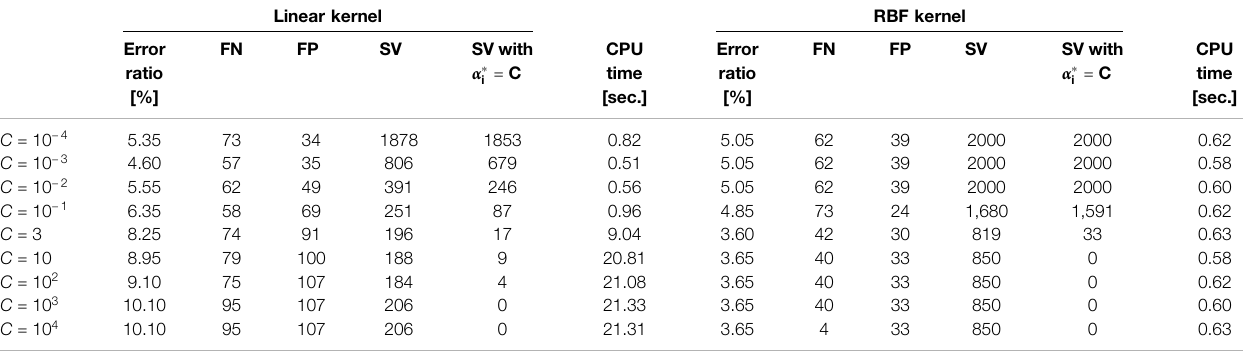
TABLE 2 | Error ratio and numbers of FN, FP, SV, and SV with α p i (cid:2) C , for various values of C using linear and RBF kernels. Linear kernel